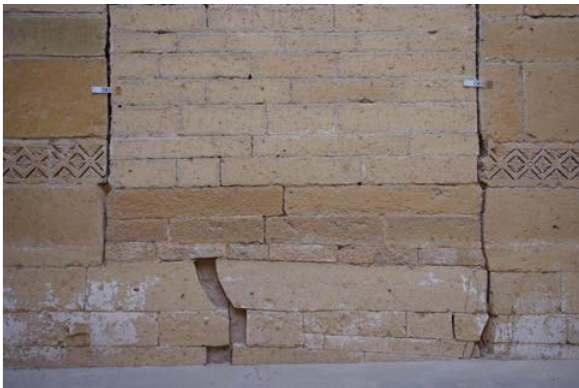
Figure 7. large cracks between the masonry infill and the original structure, 2018